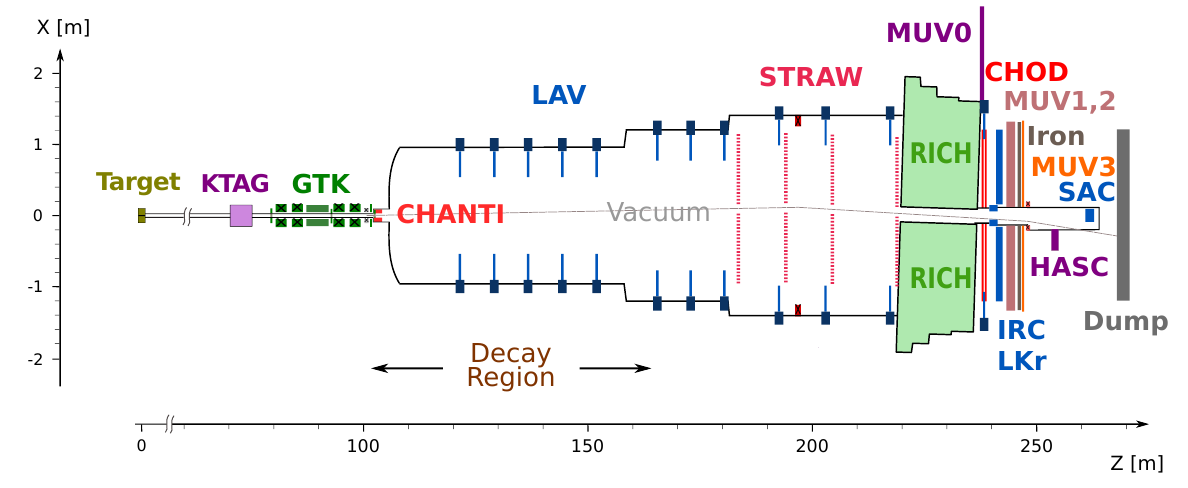
Figure 1. Schematic view of the NA62 experimental